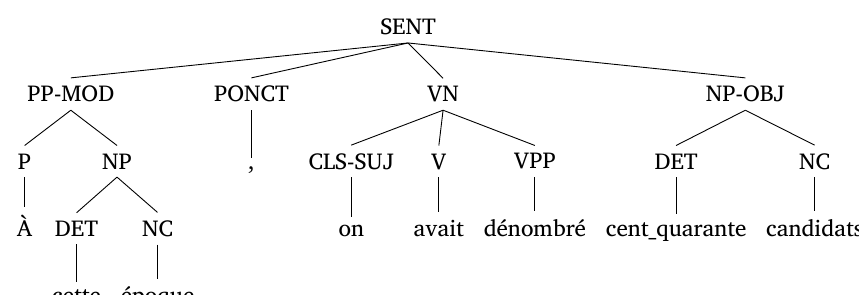
Figure 1: An example sentence from the French Treebank Moortgat and Moot (2001), Hockenmaier and Steedman (2007) and Sandillon-Rezer (2013), shown as item 2 below – with some additional rules to deal with the quirks of the format of the input treebank. A high-level description of the grammar extraction algorithm used to convert the FTB into the TLGbank is given